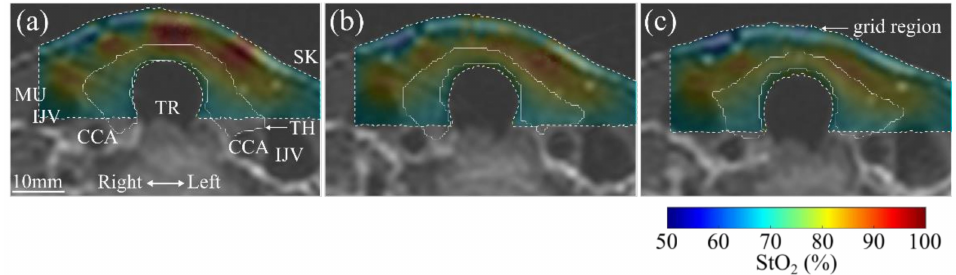
Figure 5. Tomographic images of StO 2 by the trachea–tissue boundary grid of horizontal sections at ( a ) 3 mm above the middle of the thyroid isthmus, ( b ) the middle of the thyroid isthmus, and ( c ) 3 mm below the middle of the thyroid isthmus. The T2-weighted MR images are shown in the background. The shape of the thyroid is outlined by the white line.